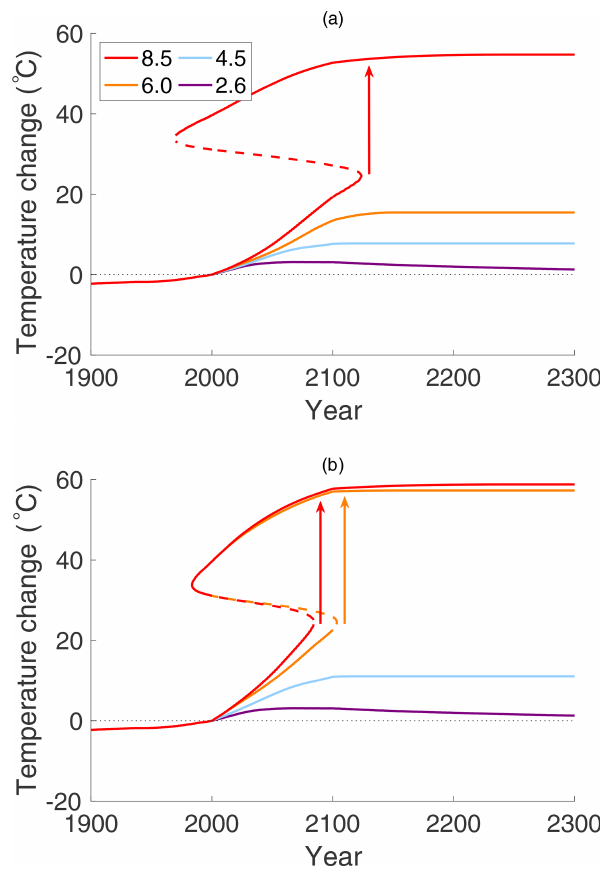
Figure 7. Arctic surface temperature change projected to year 2300 (relative to year 2000 temperature of − 28 . 90 ◦ C), with linearly in- creasing ocean heat transport F O , interpolating the data in Koenigk and Brodeau (2014); see Table 2. (a) With constant F A = 104, the jump in temperature for RCP 8.5 now occurs nearly 40 years ear- lier than for the case of constant F O shown in Fig. 6. (b) The same as (a) except that in addition to increasing F O the atmosphere heat transport F A also increases, as in Yang et al. (2016), linearly from 104 to 129Wm − 2 . Now upward transitions occur on both RCP 8.5 and 6.0, as indicated by the